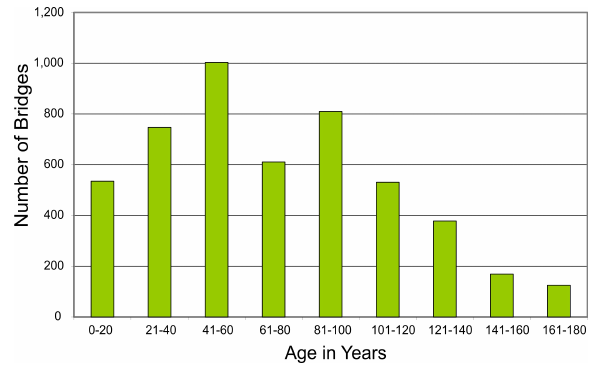
Figure 1. Age distribution of SBB